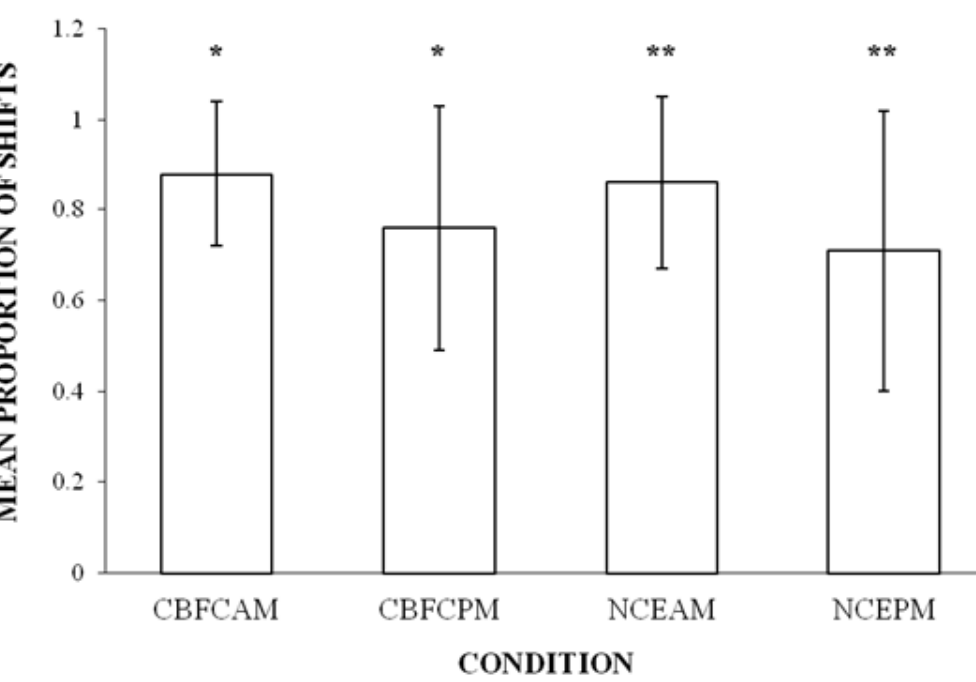
Figure 3 . The mean proportion of shifts in each condition in Stage 2.